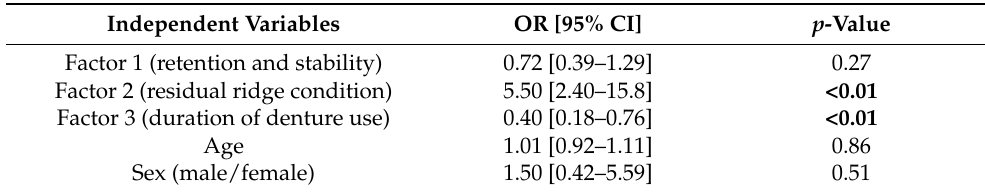
Table 5. Multivariate adjusted logistic regression analyses with denture adhesive type as the